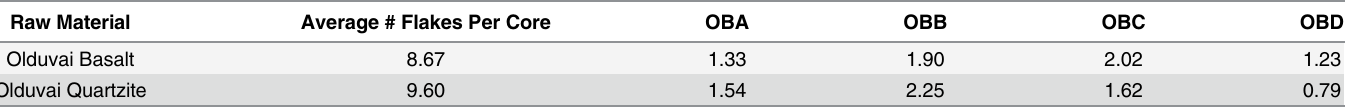
Table 3. Average number of flakes removed per core and average number of production behaviors per core for each raw material. Raw